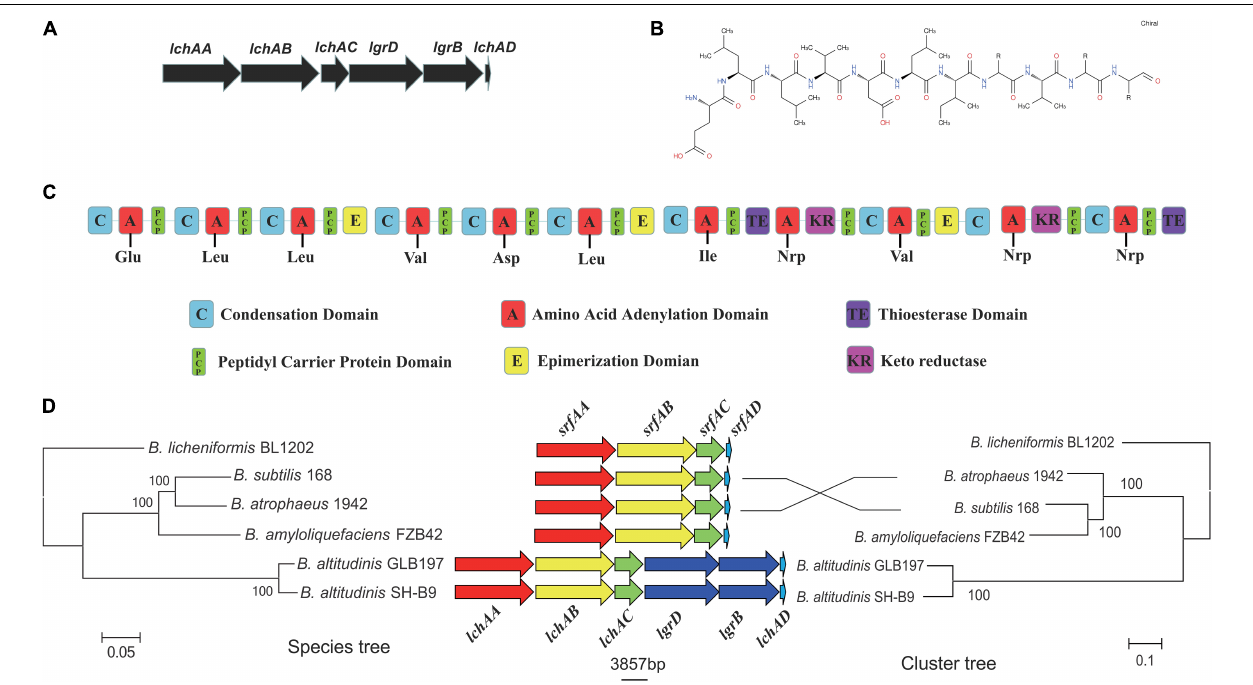
FIGURE 4 | (A) The predicted biosynthetic gene cluster of lichenysin in GLB197. (B) The predicted structures of lichenysin in GLB197. (C) The schematic representation of the entire gene cluster for lichenysin and domain organization of synthetase gene coding for lichenysin in GLB197. (D) Maximum-likelihood (ML) phylogeny of single-copy core genes (1,889 core genes) and ML species phylogeny (six cluster genes) for the Bacillus strains.